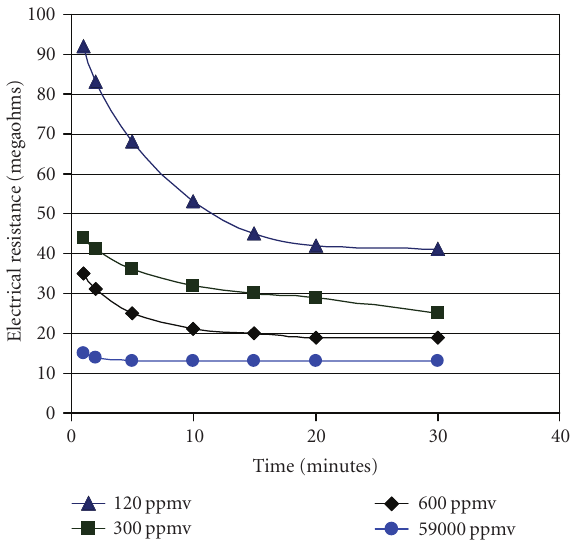
Figure 5: Response of substrates after dry air was spiked with ethanol and illuminated.